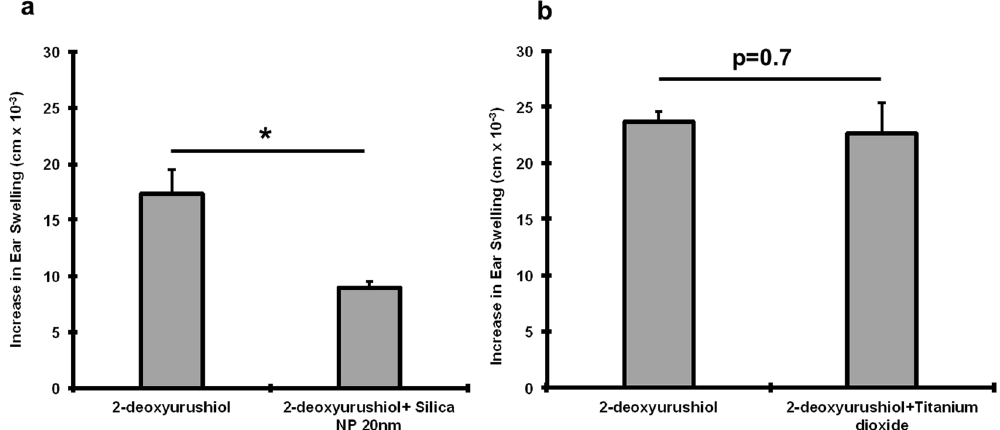
Figure 7. Co-challenge experiment with silica NP and TiO 2 NP sensitized to 2-deoxy urushiol. Mice were sensitized with 15% 2-deoxyurushiol in an acetone vehicle. The right ears were challenged with 15% 2-deoxyurushiol alone and the left ears were co-challenged with 15% 2-deoxyurushiol and ( a ) silica NP (20 nm) or ( b ) TiO 2 mixed in an acetone/olive oil vehicle. The silica NP inhibited the ear swelling response to 2-deoxyurushiol. Mean ± SEM, * p < 0.05, 2 Student’s tailed t-Test, paired with unequal variances, N =